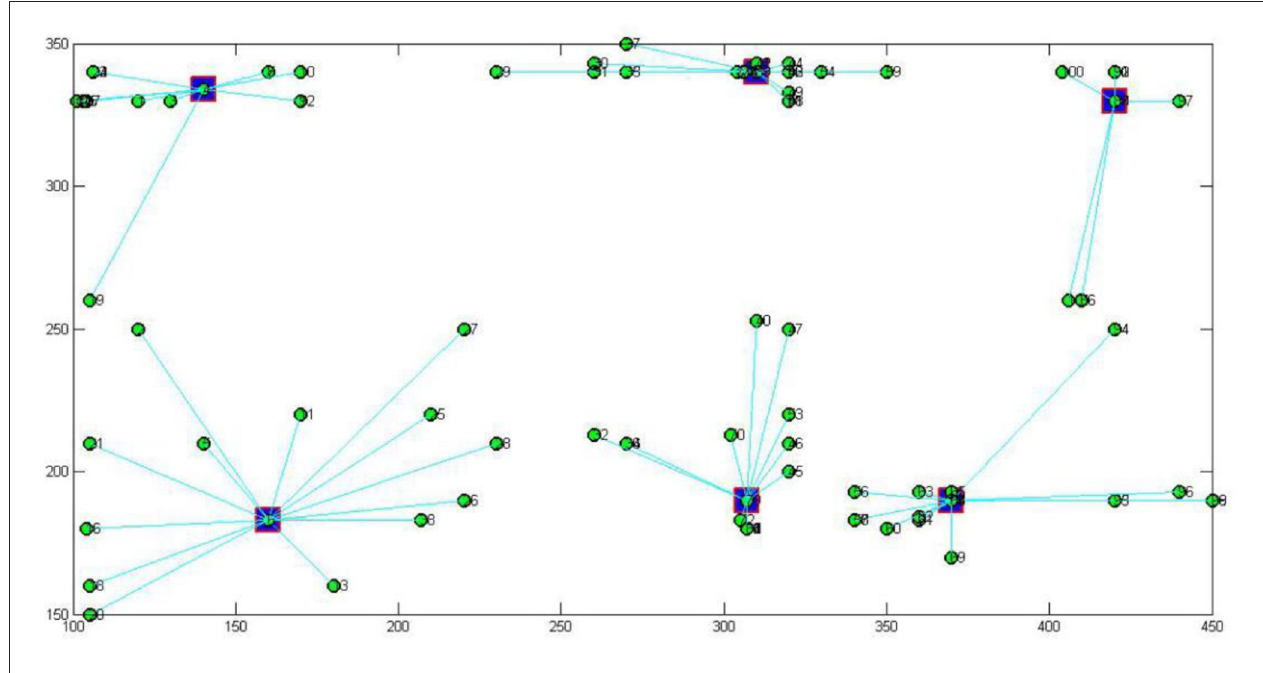
FIGURE 8 | Key Nodes in the Distribution Network of Case 3.